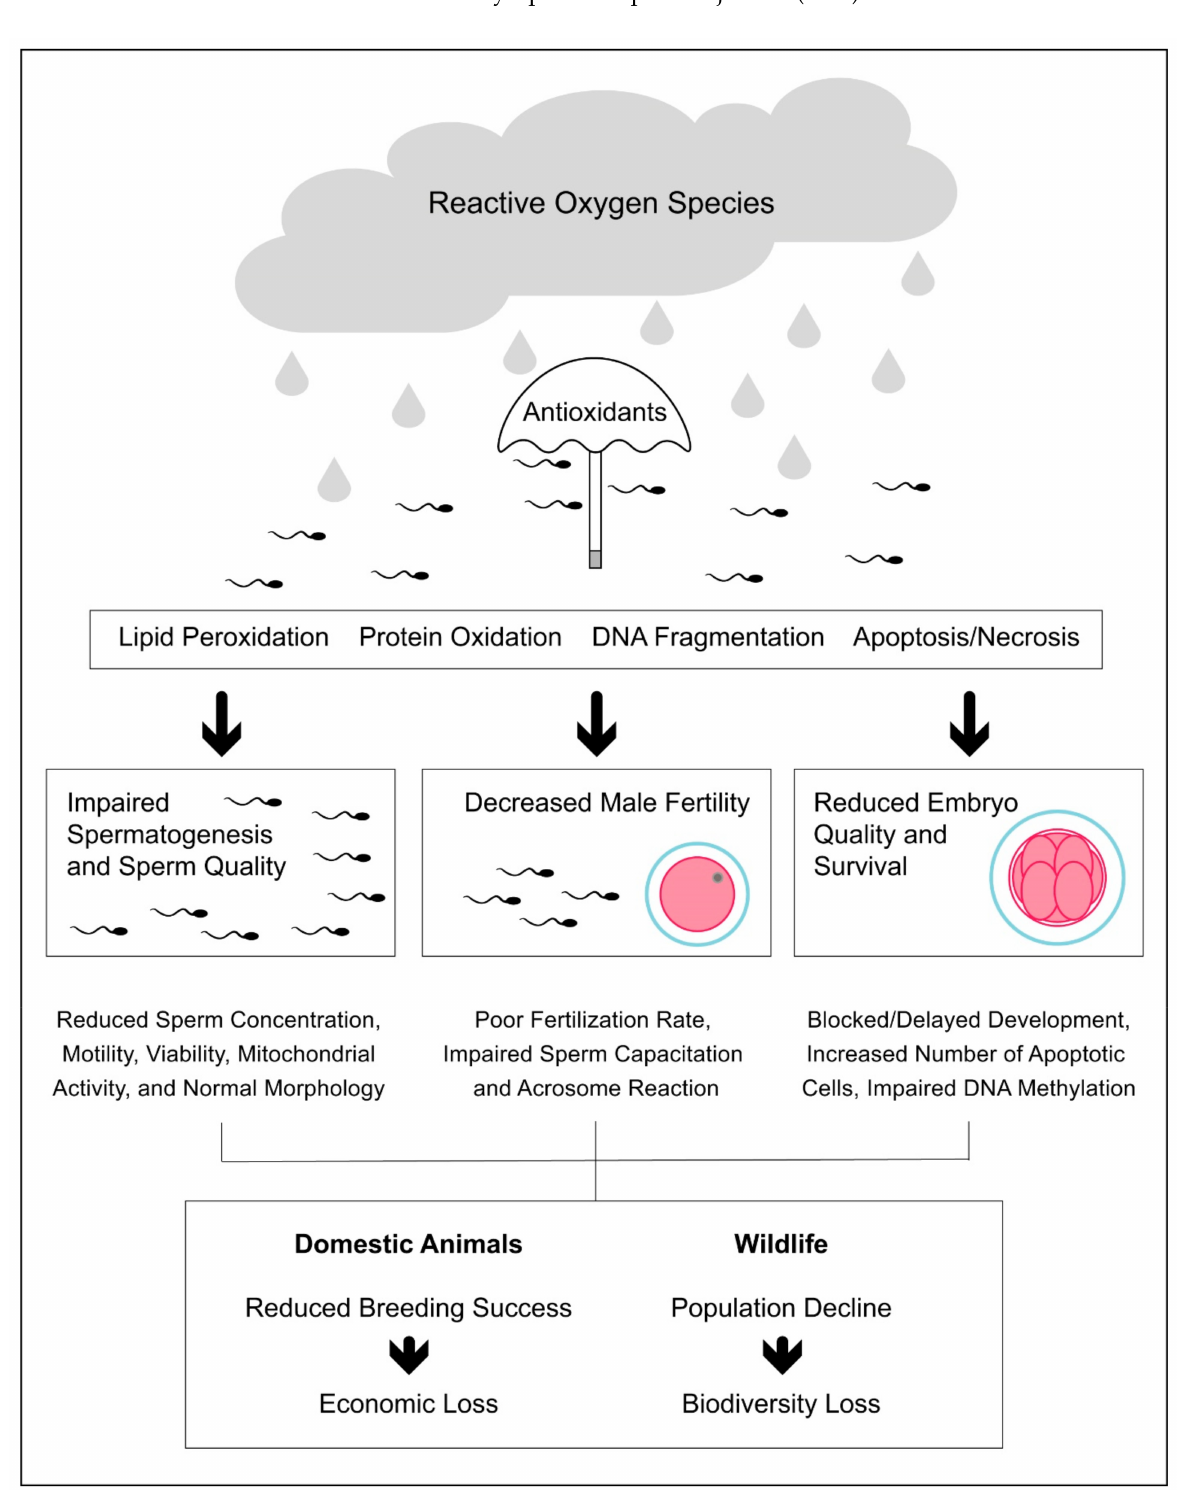
Figure 1. Impact of oxidative stress on male reproductive performance in domestic and wild